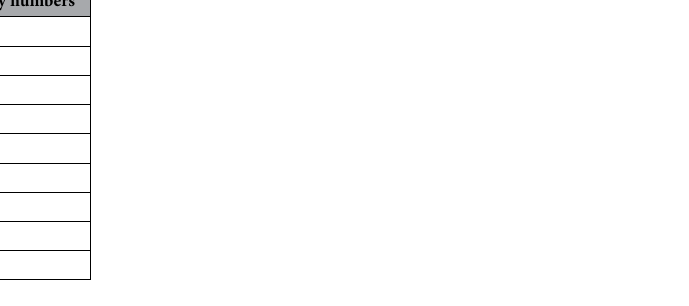
Linguistic term Triangular fuzzy